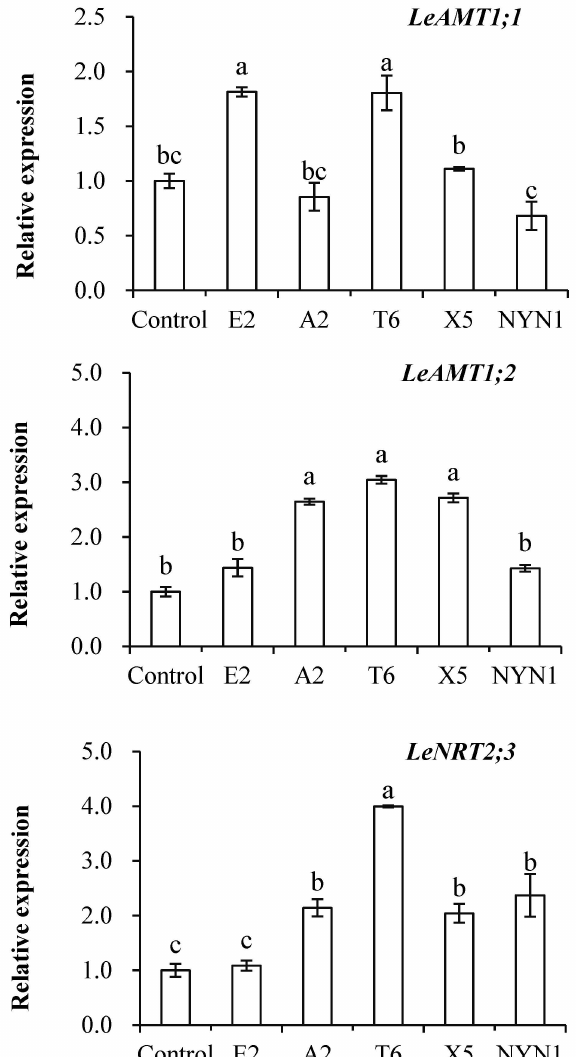
Figure 3. Effects of AMF on the expression of three nitrogen transporter genes. Different letters indicate significant differences ( p ≤ 0.05) among the different treatments after ANOVA and LSD tests. Bars are the means ± SE ( n = 4). F - LeAMT1.1 = 16.86; F - LeAMT1.2 = 19.85; F - LeNRT2.3 =